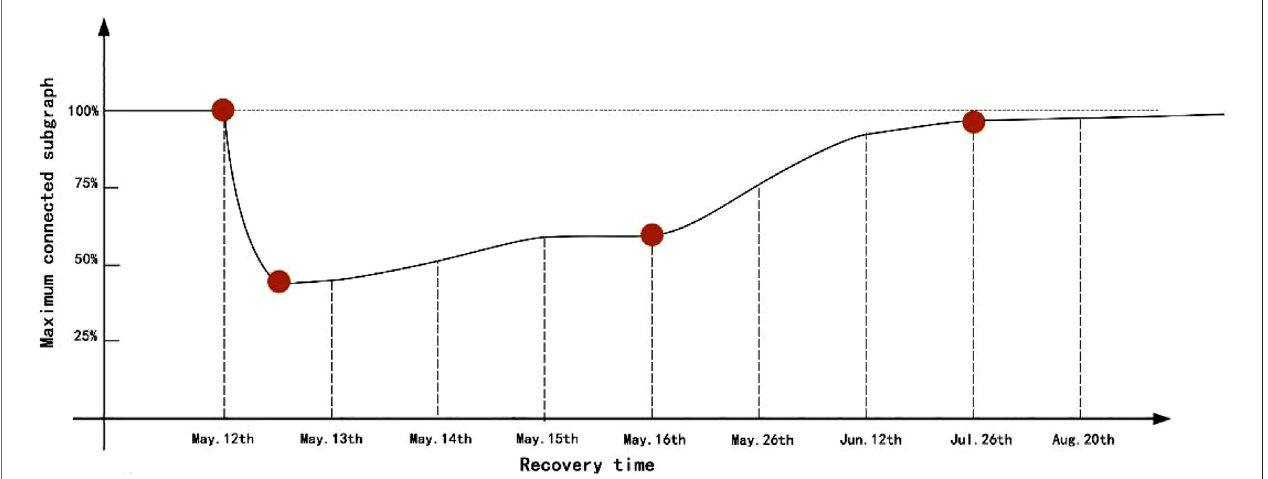
FIGURE 11 | Adaptive resilience curve characterized by the maximum connected subgraph.